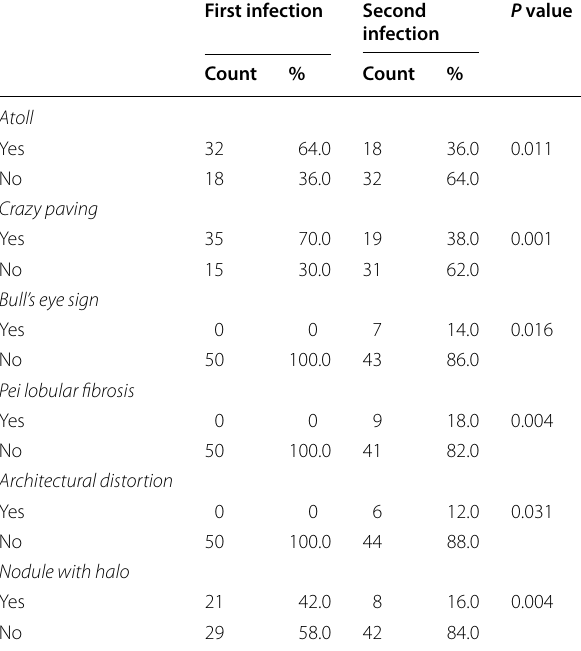
Table 5 Radiological comparison between initial infection and re-infection as regard the presence of other important radiological signs First